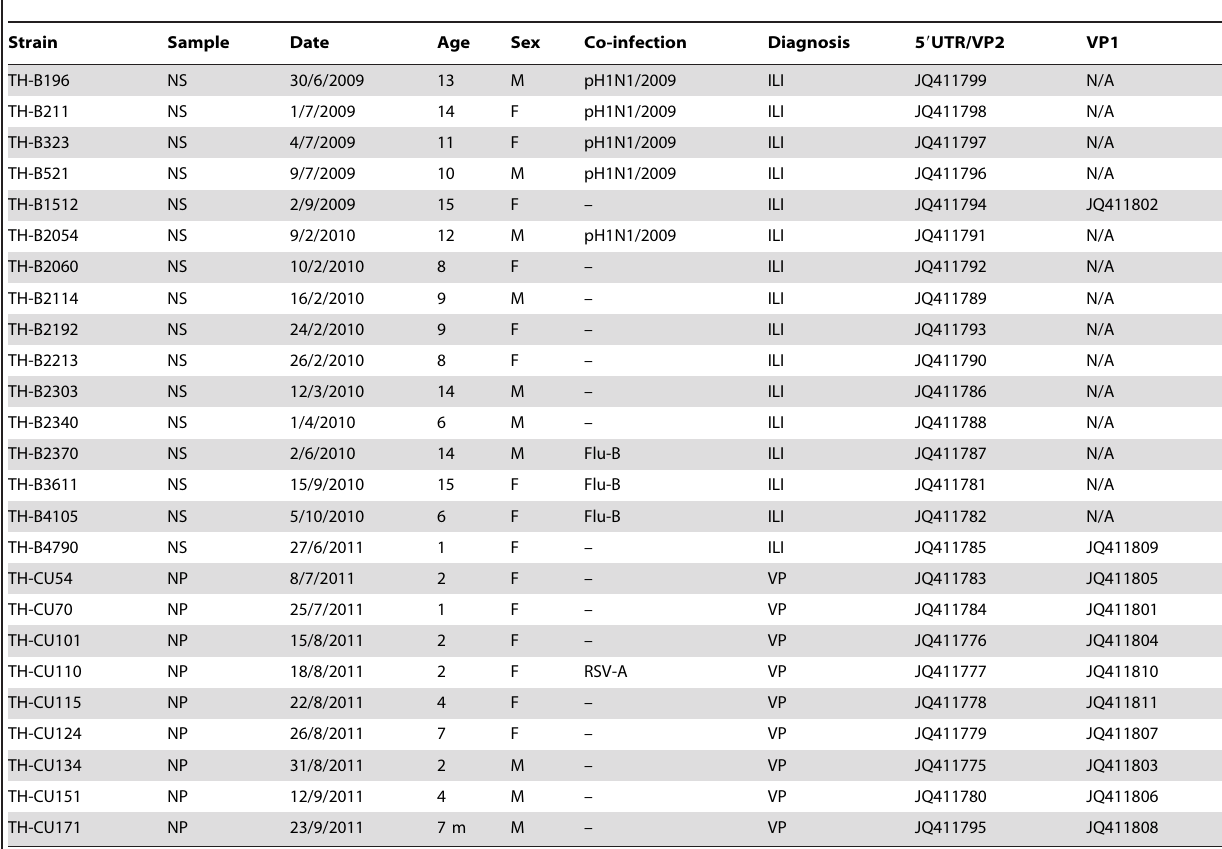
Table 3. Clinical characteristics and demographic data of the 25 cases of EV68